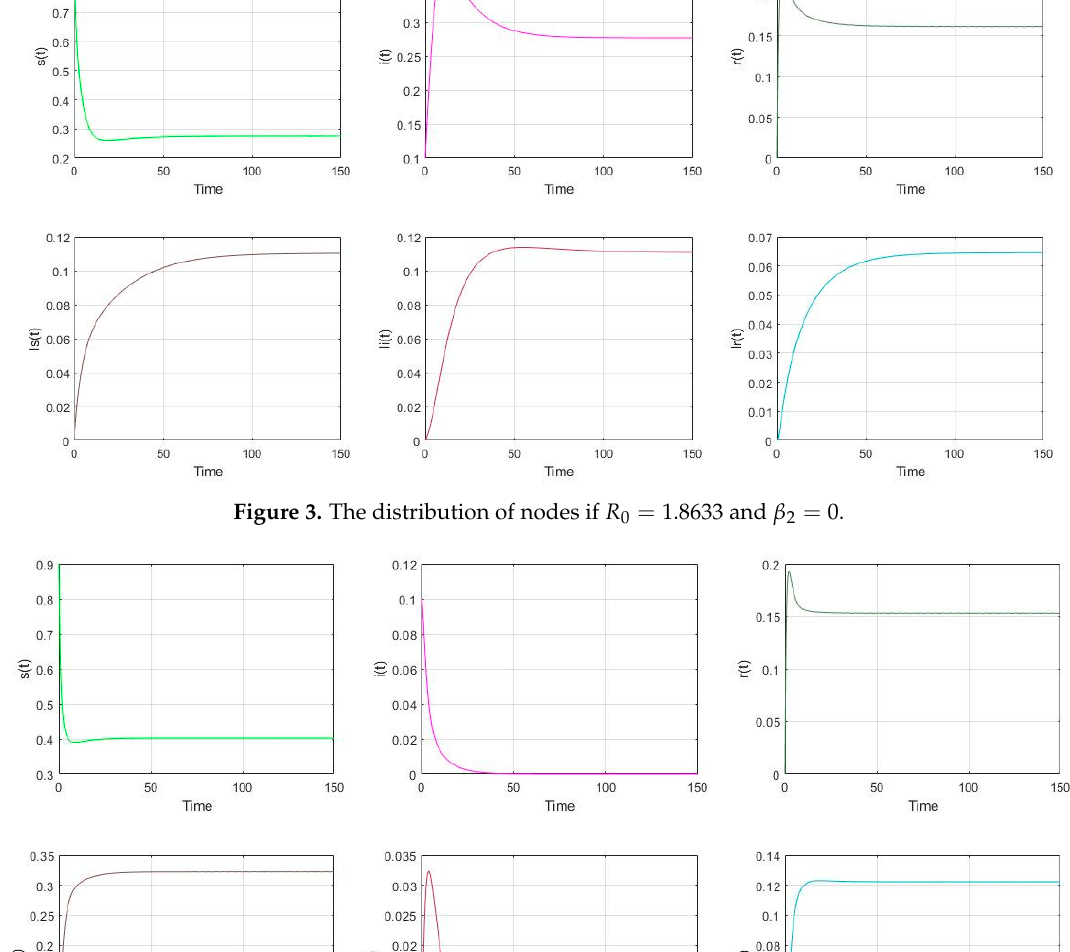
Figure 3. The distribution of nodes if 𝑅 (cid:2868) = 1.8633 and 𝛽 (cid:2870) = 0 .